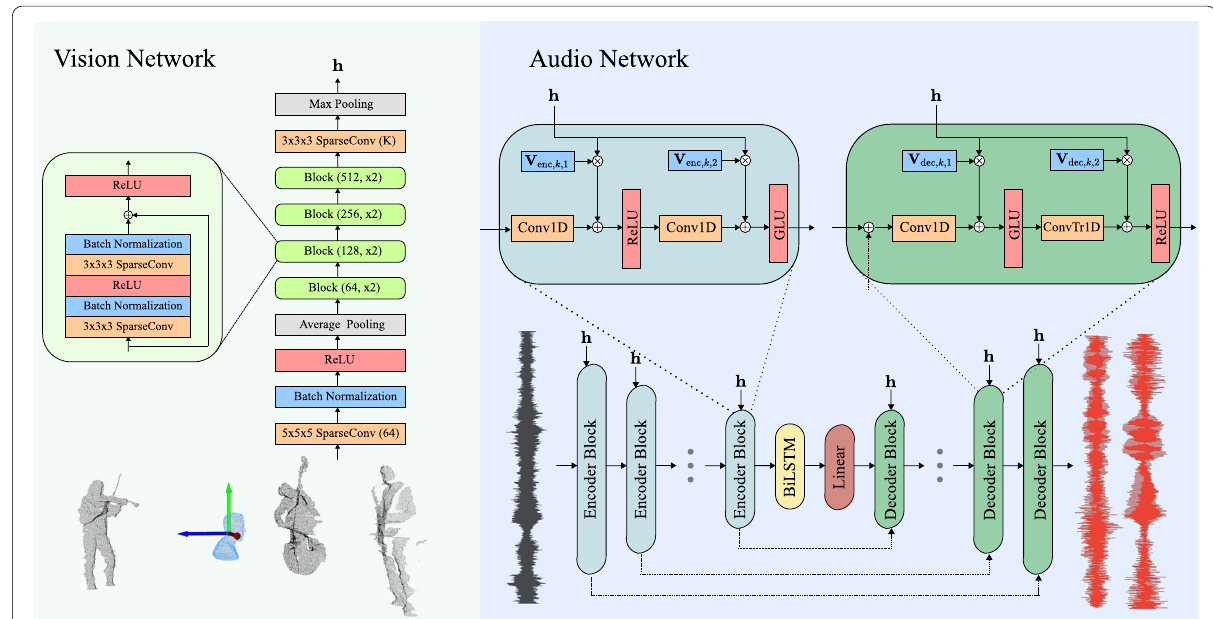
Fig. 2 Overview diagram of Points2Sound. It consists of a sparse Resnet18 network for visual analysis and a Demucs network for binaural audio synthesis. The vision network extracts a visual feature h from the 3D point cloud. Then, this visual feature serves to condition the audio network to generate a binaural version from the mono audio that matches the visual counterpart. Both networks are jointly optimized during the training of the